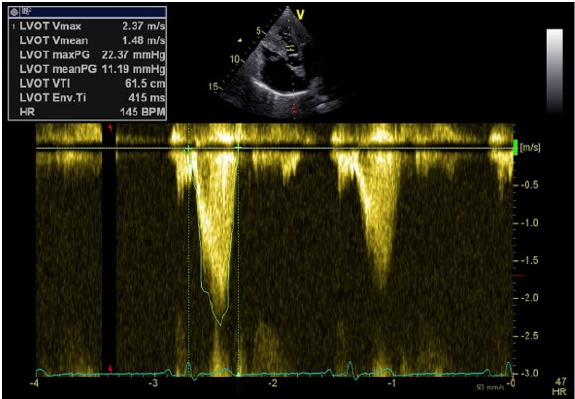
Figure 2. Typical morphological appearance of the Doppler signal “dagger − shaped” and late peaking curve in left ventricular outflow tract